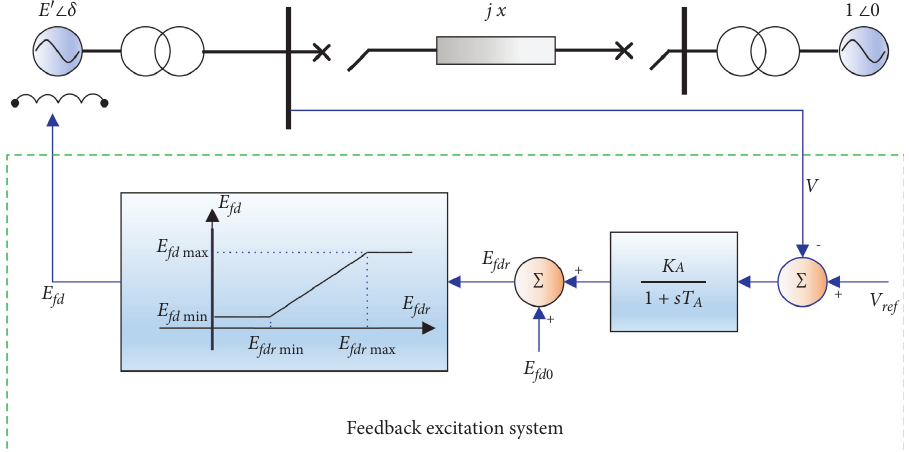
Figure 1: Power system schematic diagram.